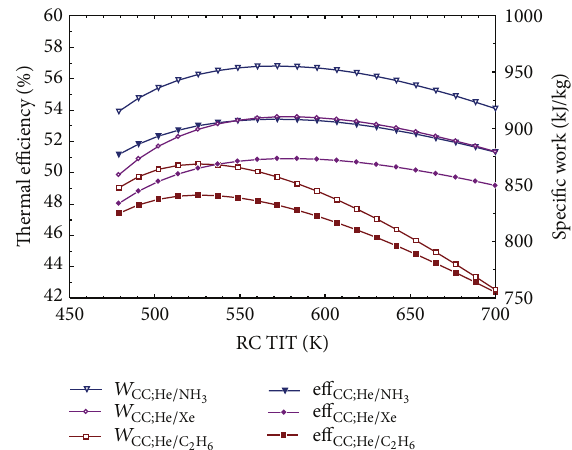
Figure 7: Thermal efficiency and specific power as function of the bottoming RC TIT for the He-NH 3 , He-Xe and He-C 2 H 6 as